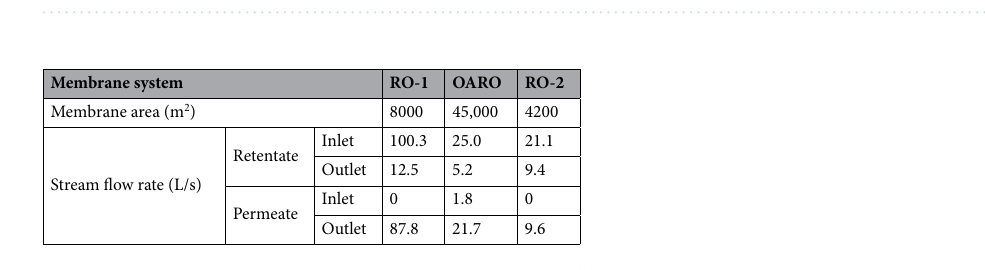
Table 6. Simulation results for the case study, described in “Novel RO separation scheme” section.